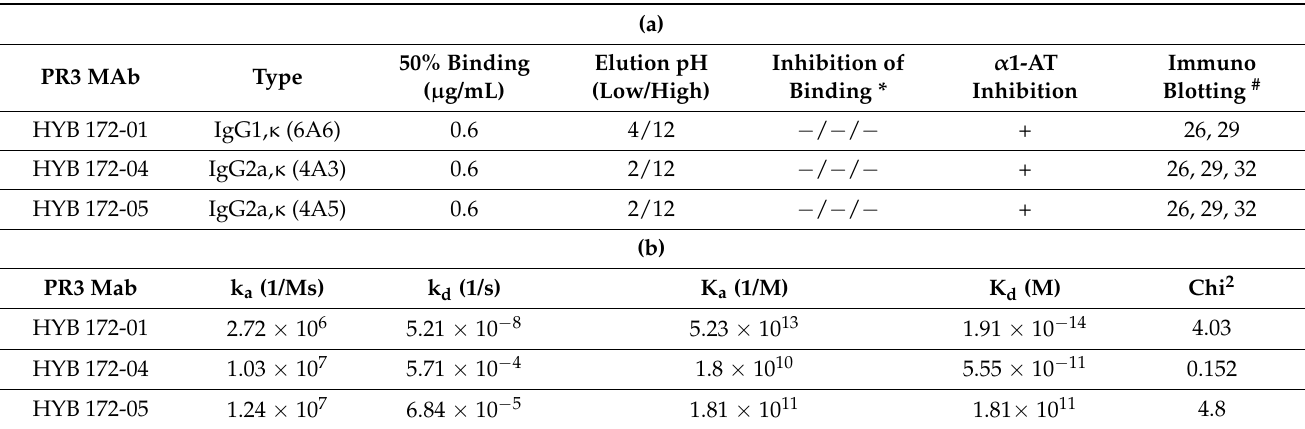
Table 2. Characteristics of PR3 MAbs. ( a ) Basic parameters. ( b ). SPR results. Kinetic binding parameters of MAbs interaction with immobilised SSI PR3 based on mathematical fitting to Langmuir and drifting base-line models.